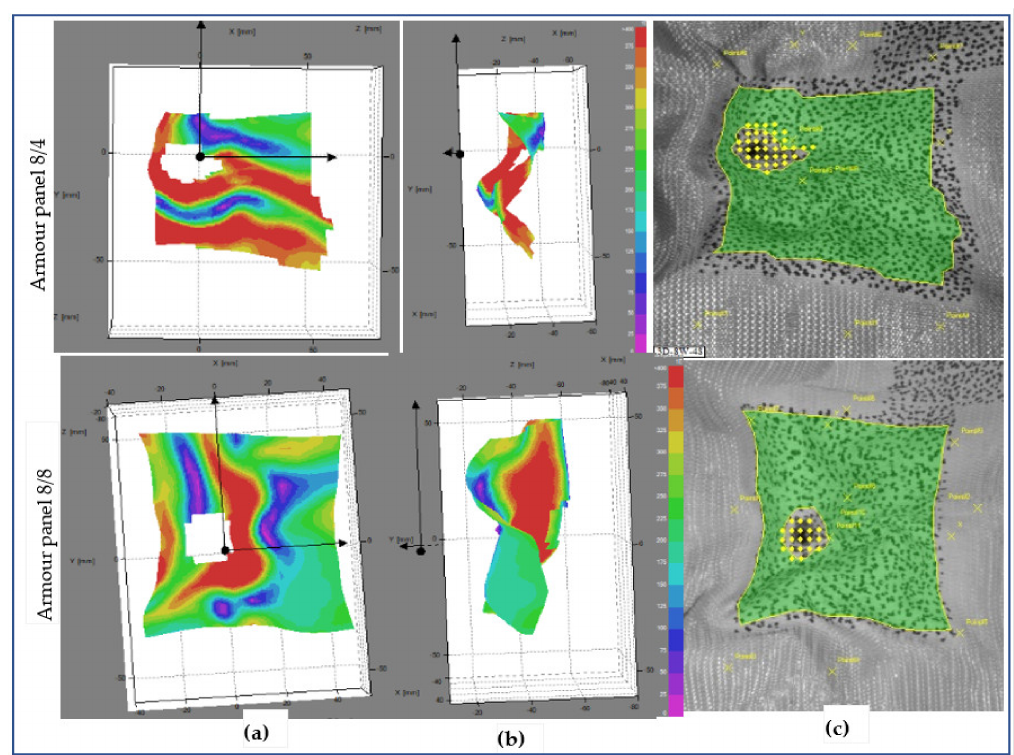
Figure 17. Surface displacement of frontal armour panel at impact times of 3.6 ms ( a , b ), 3D frontal and side views of stereoscopic images, respectively, and ( c ) frontal panel images at shot point 3.